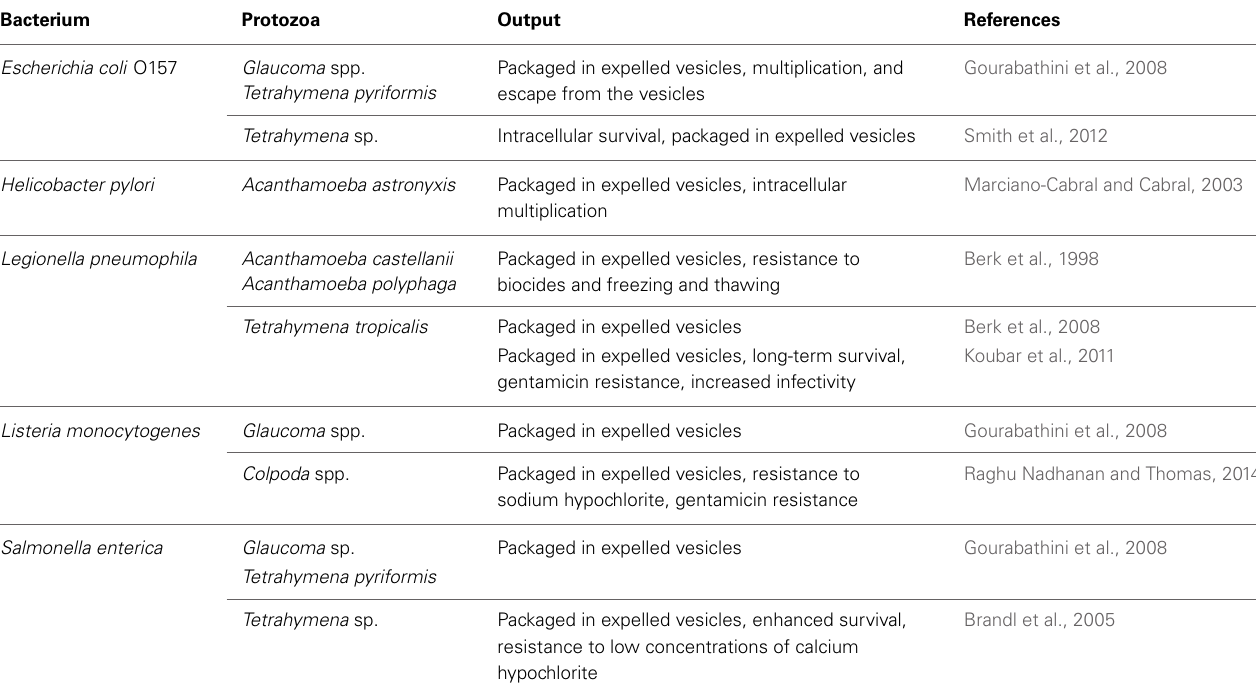
Table 2 | List of bacteria-protozoa combinations where bacteria packaging has been observed.